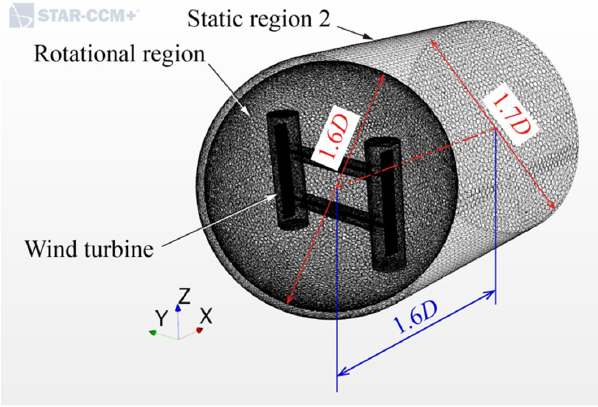
Figure 4. Computational regions around a wind turbine rotor model.